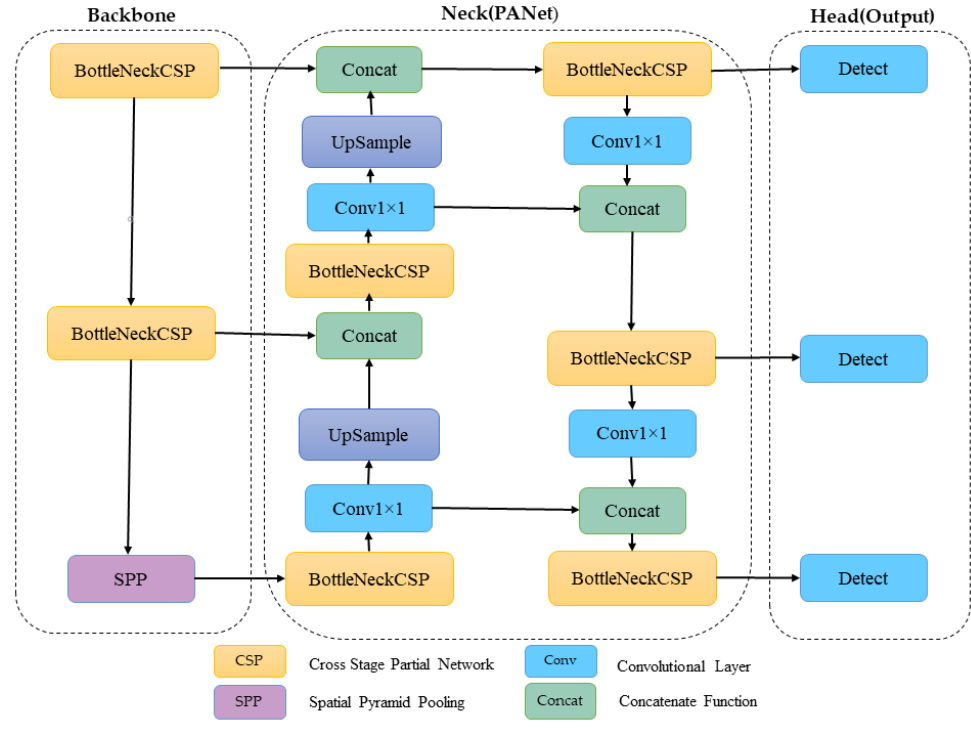
Figure 5. The general architecture Yolov5